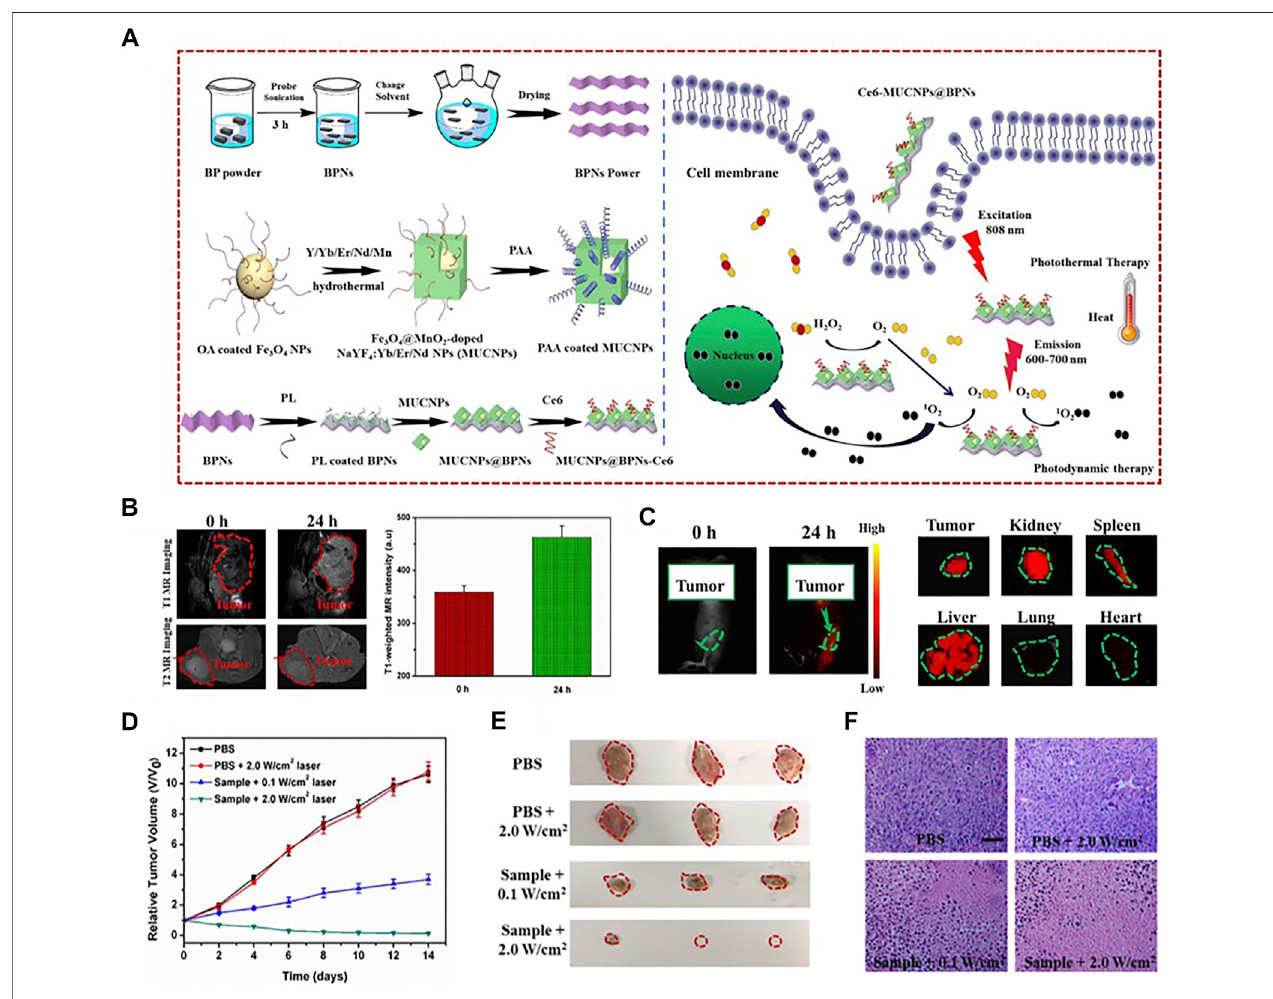
FIGURE7|(A) SchematicillustrationofthefabricationofMUCNPs@BPNs-Ce6anditsantitumortherapy. (B) Invivo MRimagesand T 1 -weightedMRsignalsinthe tumor before and after injection with MUCNPs@BPNs-Ce6 for 24 h. (C) In vivo and representative ex vivo fl uorescence images of Hela tumor – bearing mice. (D) In vivo tumor volume curves of tumor-bearing mice in different groups after various treatments indicated. (E) Photographs of excised tumors. (F) HE staining of tumor tissue (scale bar = 100 μ m). Reproduced with permission from Zhang et al. (2020). Copyright 2020, Elsevier.